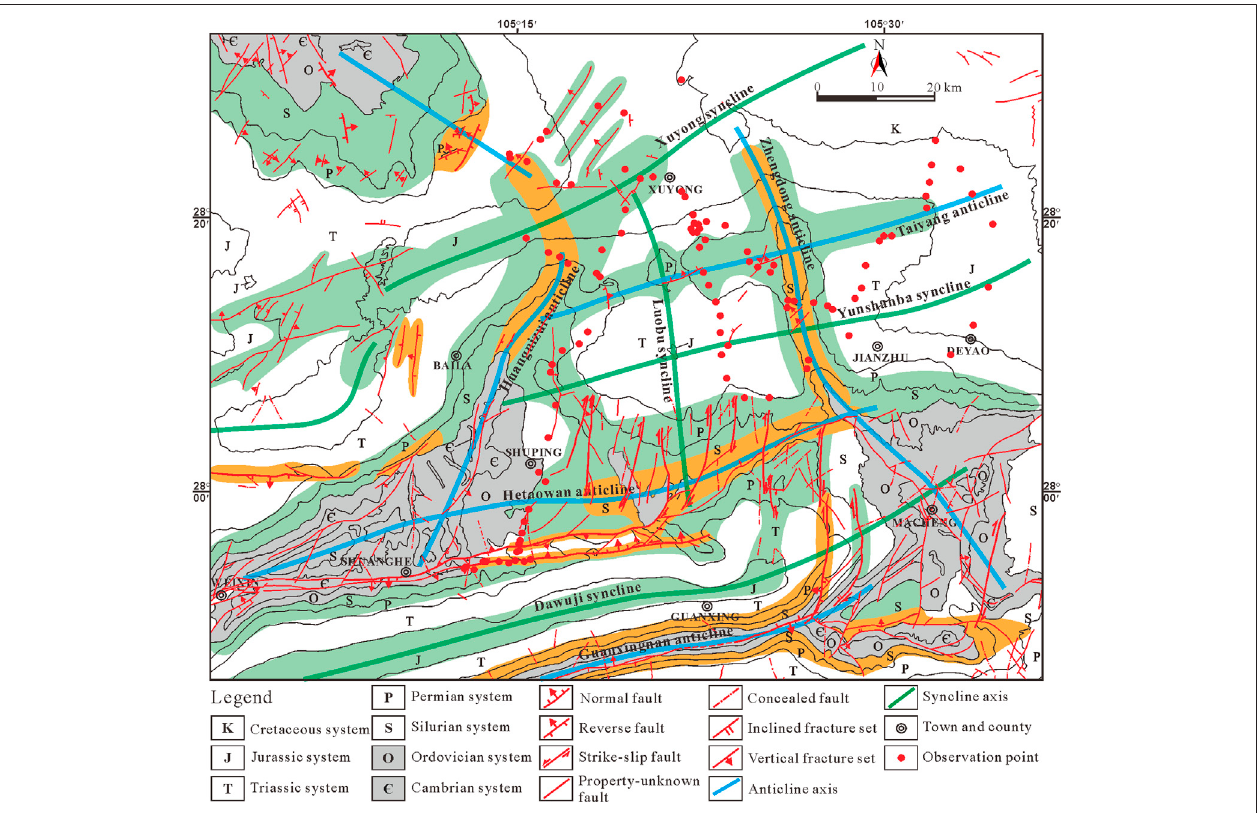
FIGURE9| Predicteddistributionrulesofdifferentshaledeformationstructures.Notes:Light greenareas developmedium-intensitybrittledeformationstructures, such as cataclastic and platy structure. Orange areas develop strong deformation structures, such as porphyritic, fl aky, fractured-crumpled, scaly, and crumpled, and mylonitized structure. Gray areas means the eroded areas of the Wufeng – Longmaxi Formation. White areas develop primary structure and weak brittle deformation structures.